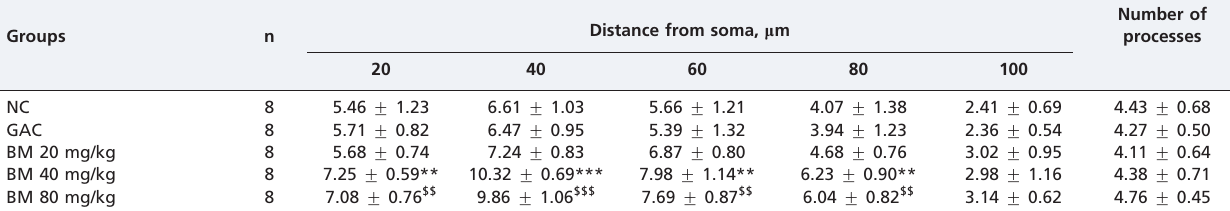
Table 1 - Basolateral amygdaloid neuronal dendritic intersections and the number of dendritic processes arising from the somata (4-week